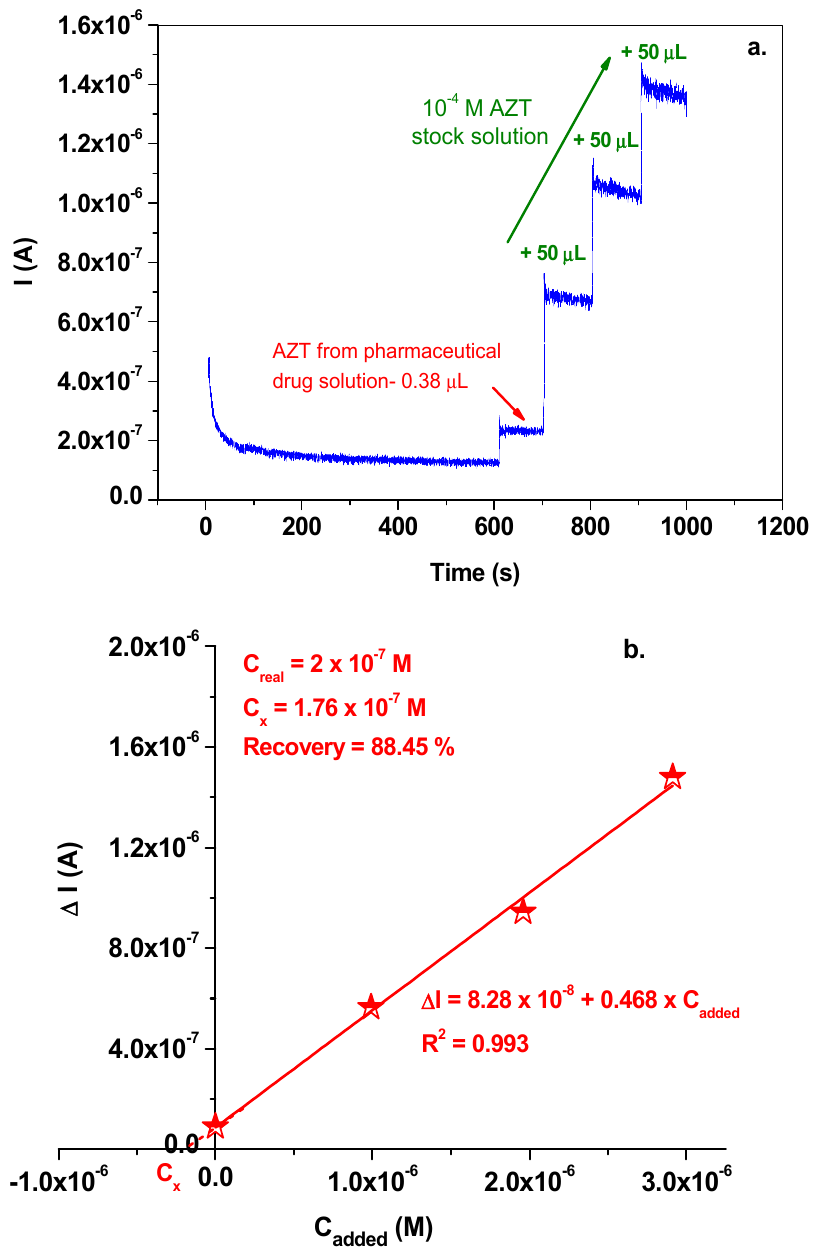
Figure 11. Amperometric curve recorded with EGr/GC electrode in pH 5 acetate after the addition of AZT pharmaceutical drug solution (0.38 µ L; 2.6 × 10 − 2 M) and three additions of 50 µ L of AZT